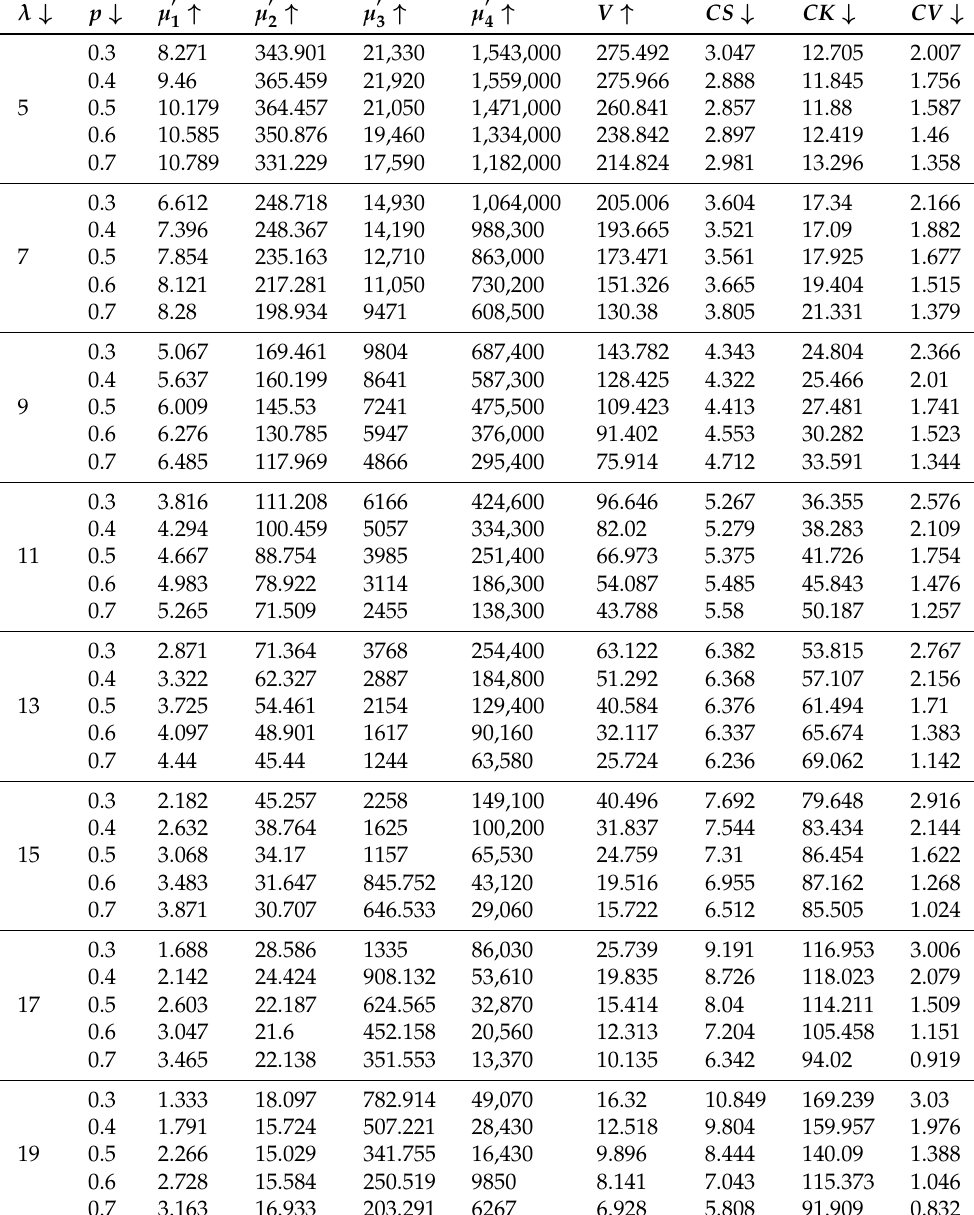
, µ (cid:48) , µ (cid:48) , µ (cid:48) , V , CS , CK and CV for the FB model at β = 0.5 and n = 2 3 1 4